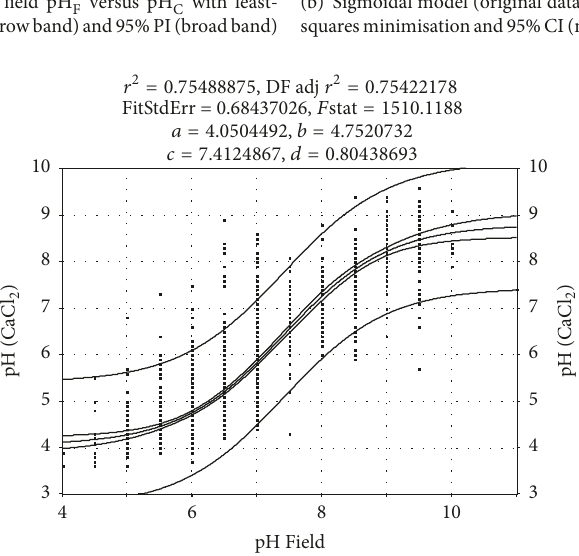
(a) Linear model (original data) for field pH F versus pH C with least- squaresminimisationand95 % CI(narrowband)and95 % PI(broadband)